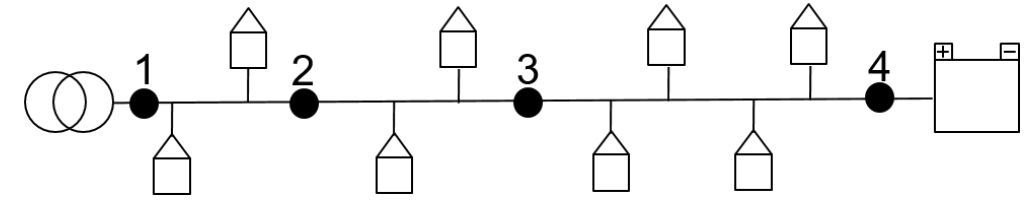
Figure 1. Structure of the low voltage